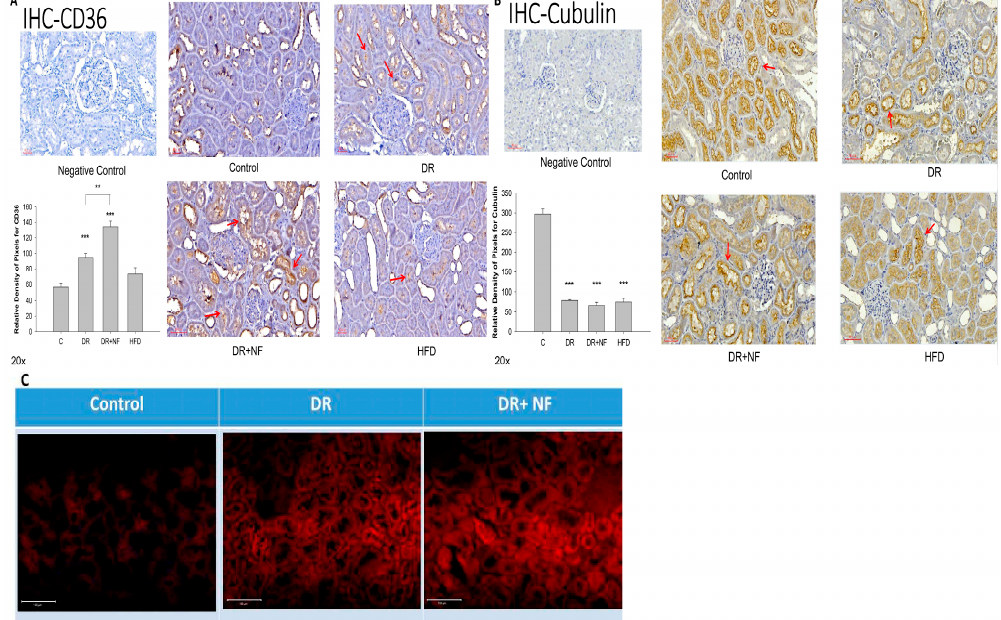
Figure 4. Immunohistochemistry (IHC) of CD36 and cubilin and fluorescent staining for Nile red in rats. ( n = 3 for each group) ( A ) In kidney tissue, CD36 is highly expressed (red arrow) in the DR group compared to the control. (*** p < 0.01) The DR+NF group also had higher CD36 expression than the DR group. ( ## p < 0.05) ( B ) The expression of cubilin (red arrow) decreased in the DR, DR+NF, and HFD groups compared to that in the control (*** p < 0.01). ( C ) Nile red fluorescent staining showed that the DR+NF group had the highest amount of lipid accumulation (red dye), followed by the DR group, compared to the control (magnification 200×).